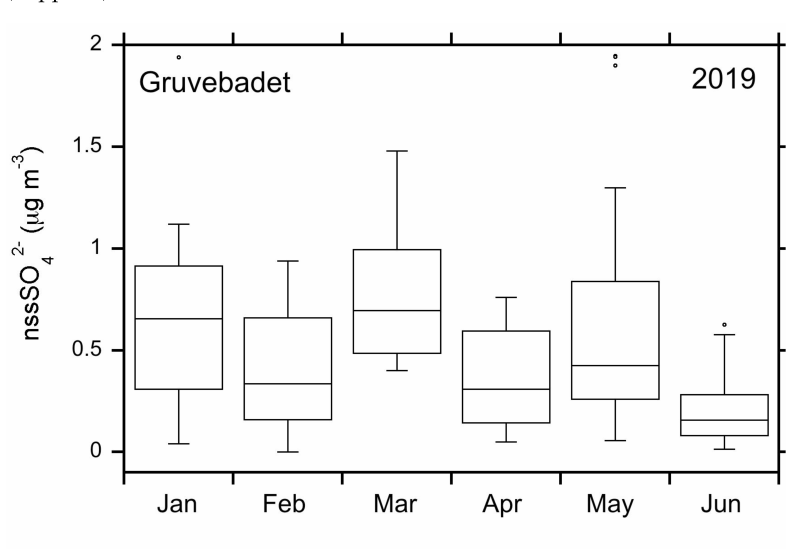
Figure 11. nssSO 2 − concentrations for spring 2019 at the village (Gruvebadet) and the mountain 4 (Zeppelin) station.